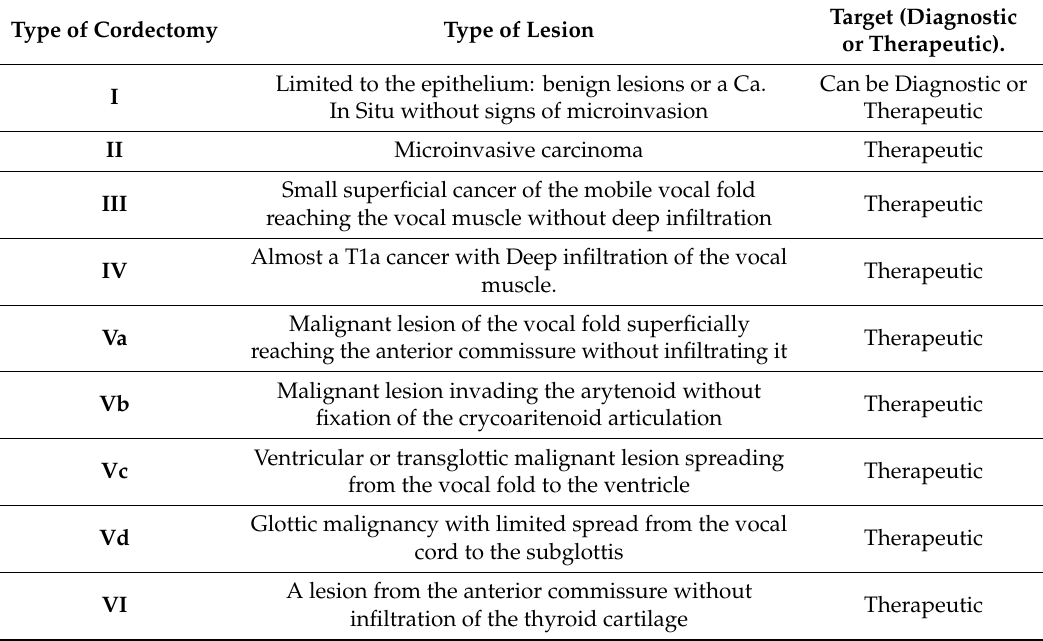
Table 1. Endoscopic cordectomy classification of the European laryngological society. Type of Cordectomy Type of Lesion